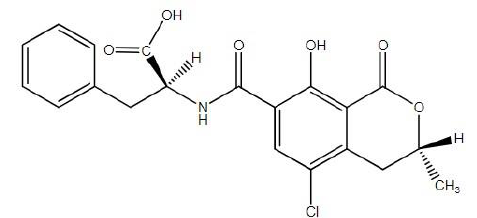
Figure 2. Chemical structures of ochratoxin A.